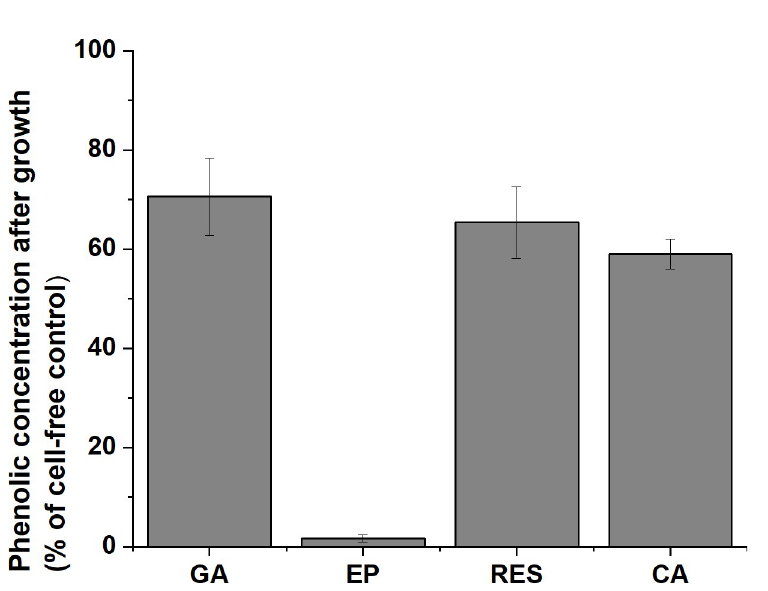
Fig 3. Depletion of phenolic compounds by growth of X . fastidiosa . Percent of gallic acid (GA), epicatechin (EP), resveratrol (RES), or coumaric acid (CA) remaining in cell-free supernatants after 7 days with X. fastidiosa cells. Media was supplemented with GA (1000 μ g/ml), EP (200 μ g/ml), RES (15 μ g/ml), or CA (60 μ g/ml). Bacterial cells were removed by filtering prior to measuring concentrations of gallic acid, epicatechin, resveratrol, or coumaric acid by HPLC. Data are expressed as means + standard deviation of three independent experiments (n = 3 replicates per experiment). Significant differences in the amount of compound remaining were compared by the Mann-Whitney Rank of Sum Test (T = 126, n = 9, p-value < 0.001) and significance is indicated by asterisk.